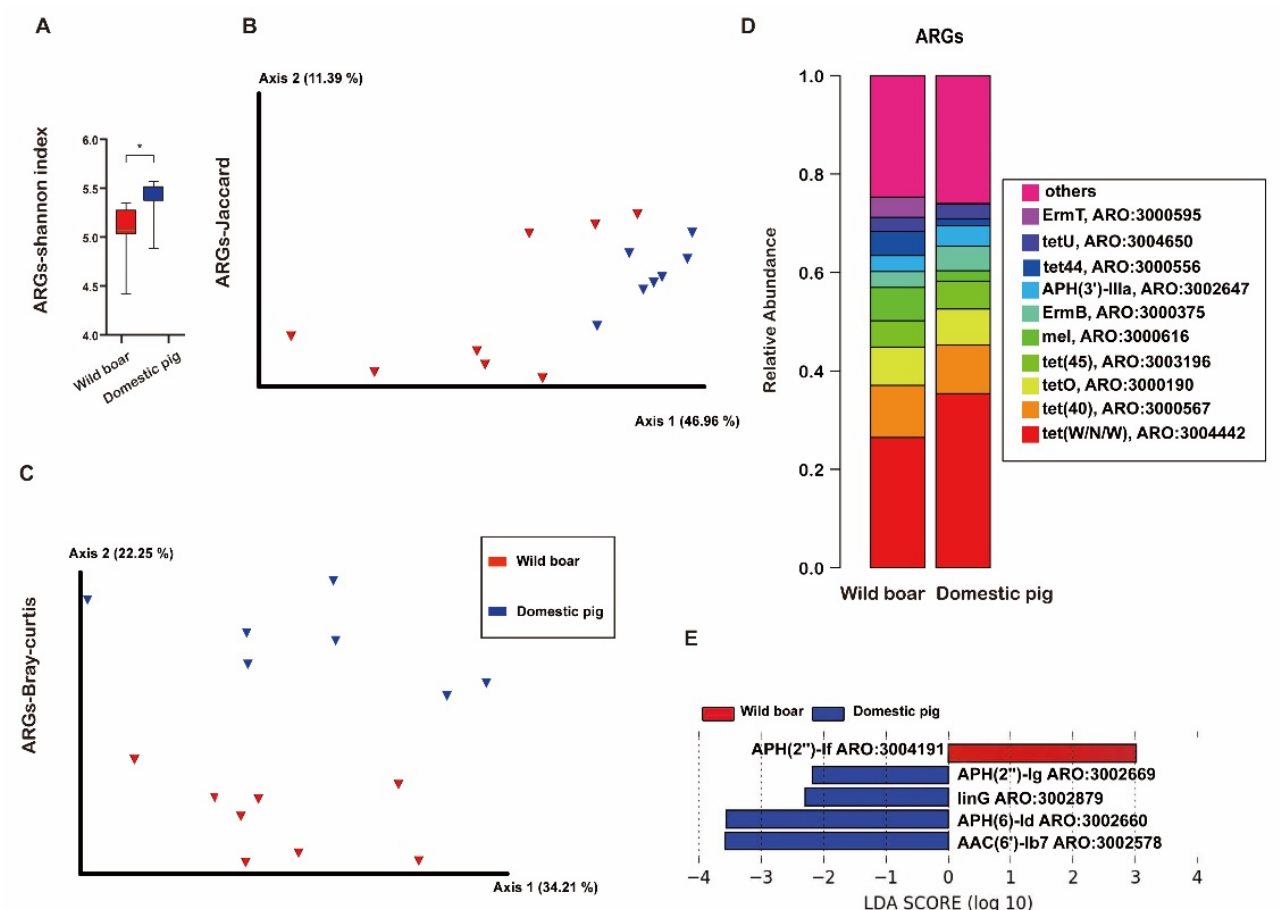
Figure 8. The comparison of ARGs between domestic pigs and wild boars. Alpha diversity is Shannon index ( A ), * p < 0.05, Mann–Whitney U-test. Red and blue bars represent wild boar and domestic pigs, respectively. ( B ): Principal Coordinate Analysis (PCoA) of ARGs based on Jaccard distances. ( C ): Principal Coordinate Analysis (PCoA) of ARGs based on Bray–Curtis distances. ANOSIM, p < 0.05, red and blue circles represent bacterial communities of pigs in the wild boar and domestic pig groups, respectively. ( D ): Top10 ARGs classification of domestic pigs and wild boars. ( E ): The LEfSe analysis of ARGs between wild boars and domestic